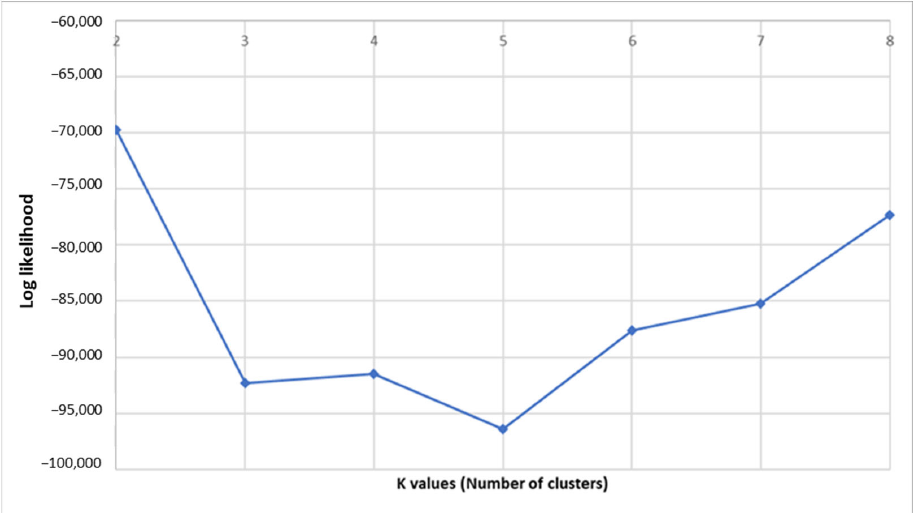
Figure 3. Log likelihood (average of 10 runs) for various K values from the admixture model run on the whole population of 555 C. arabica samples.